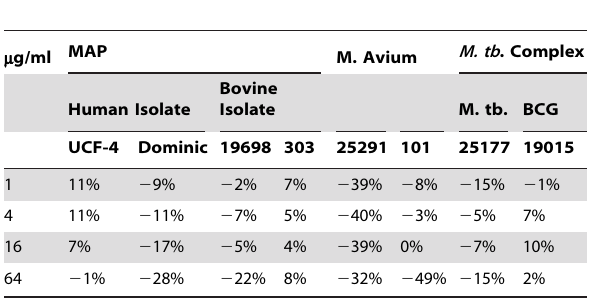
Table 6. Vitamin K1.